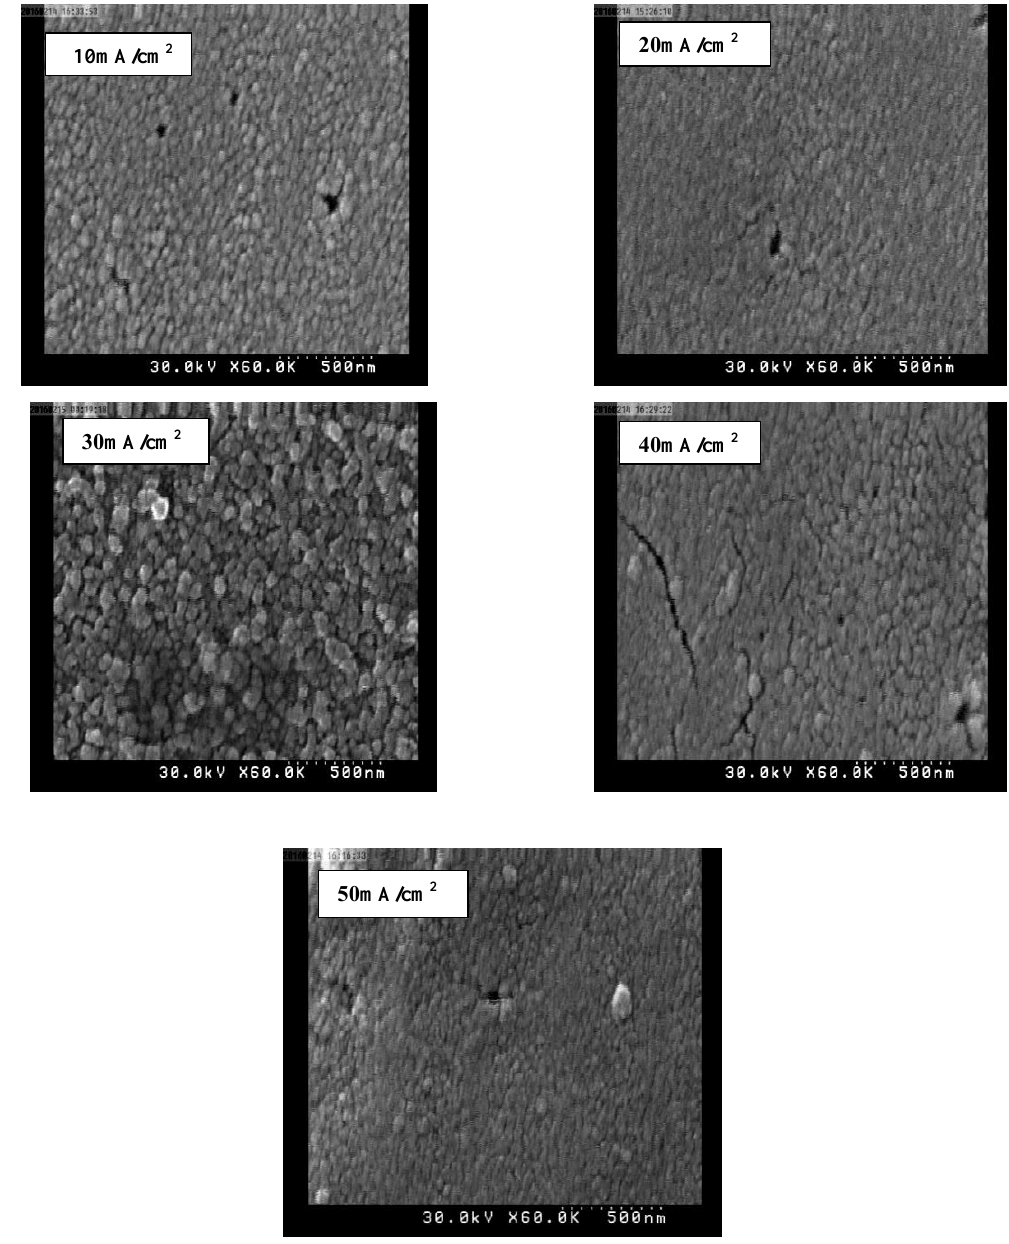
Fig. 5: FESEM image of n-type porous silicon surface with different current density 10, 20, 30, 40 and 50